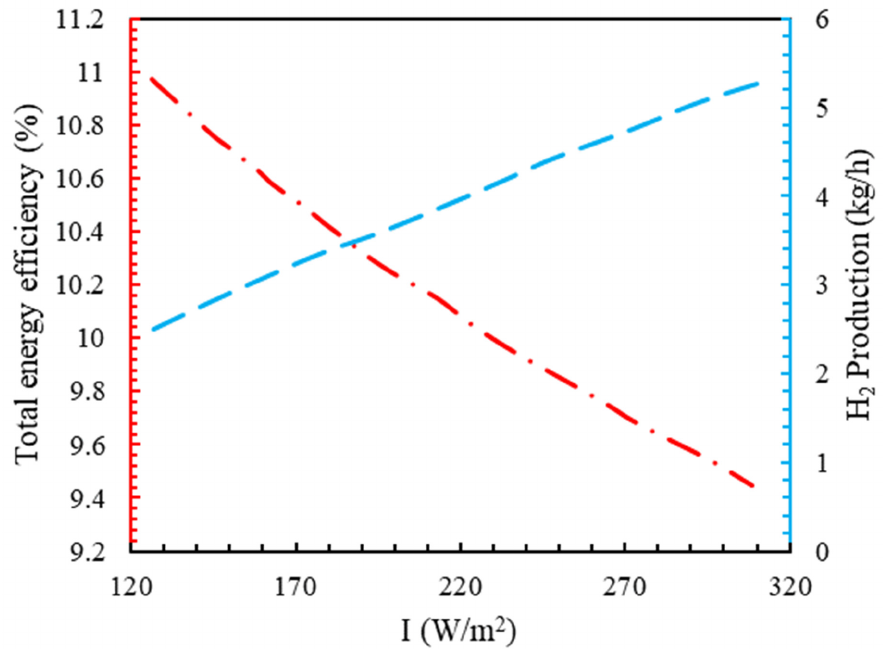
Figure 11. The effect of solar radiation on hydrogen production and overall energy efficiency.